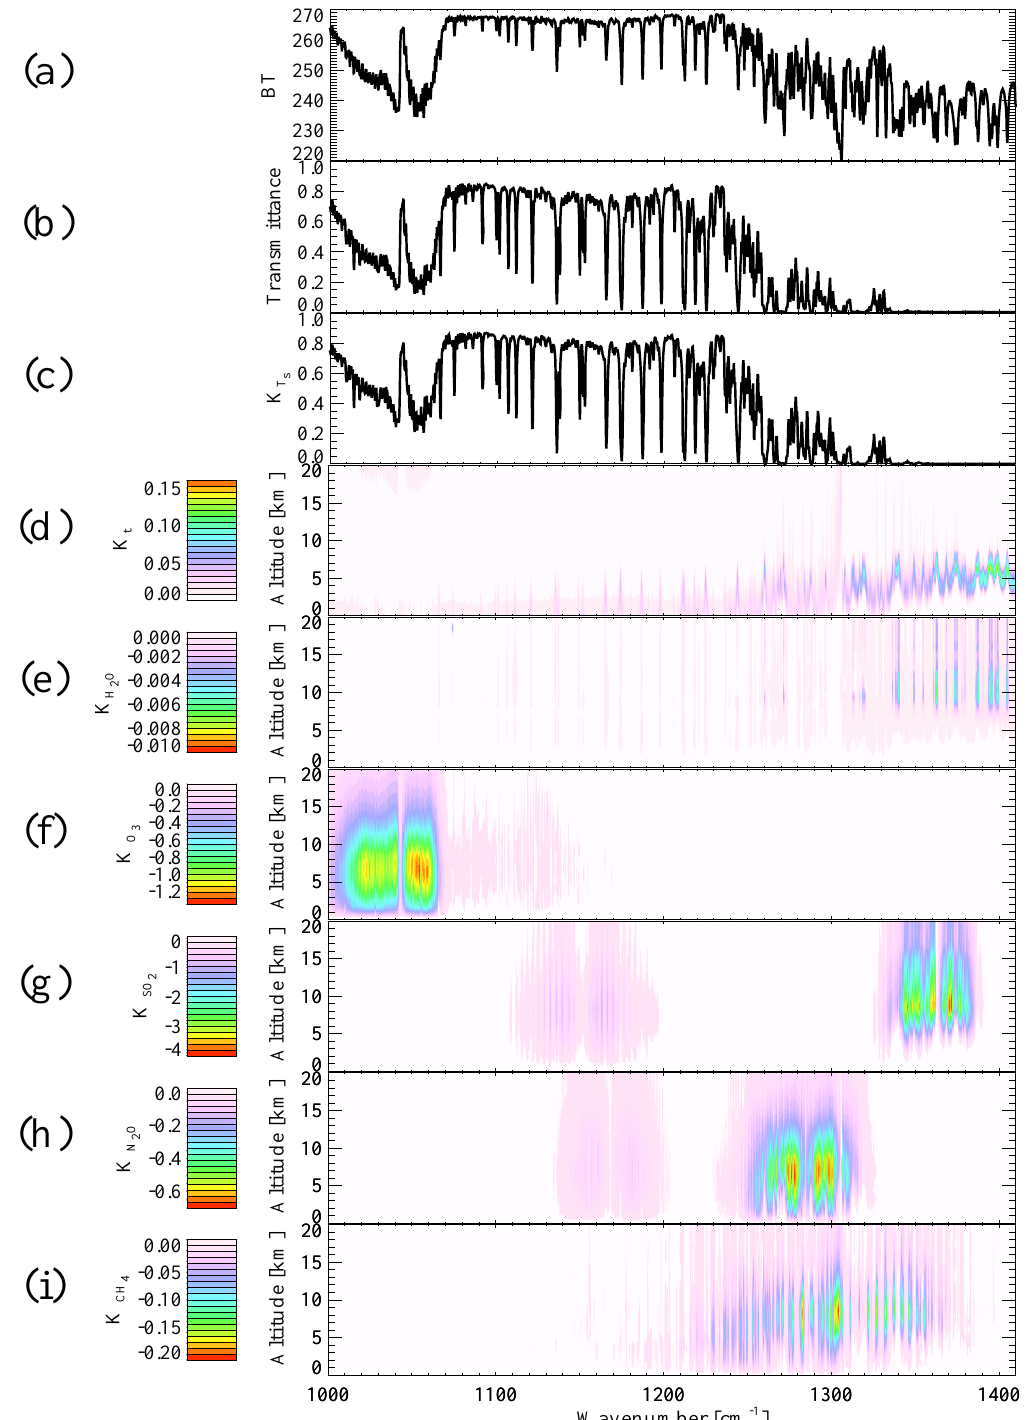
Fig. 1. (a) Simulated IASI brightness temperature for the reference clear atmosphere, (b) the ground to space transmittance for this atmo- sphere, (c) the surface temperature weighting function ( K T ), (d) the atmospheric temperature weighting function ( K T ), (e) the water vapour s weighting function ( K H ), (f) the ozone weighting function ( K O ), (g) the sulphur dioxide weighting function ( K SO 2 O 3 weighting function ( K N ), (i) the methane weighting function ( K CH 2 O 4